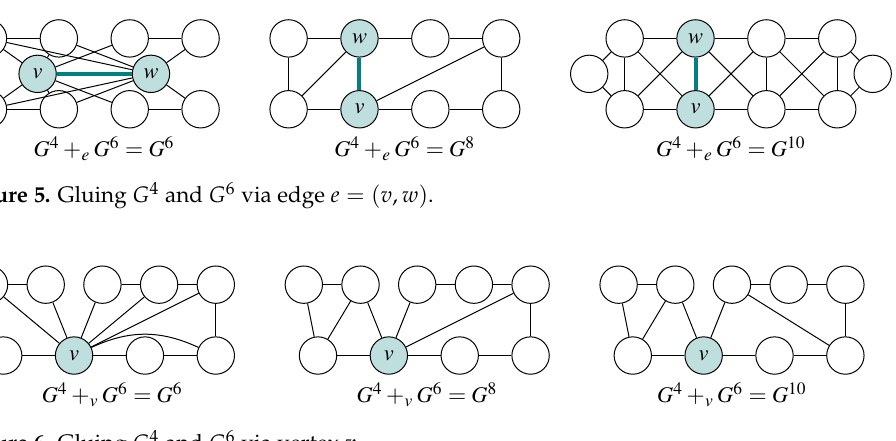
Figure 6. Gluing G 4 and G 6 via edge e = ( v , w ) .